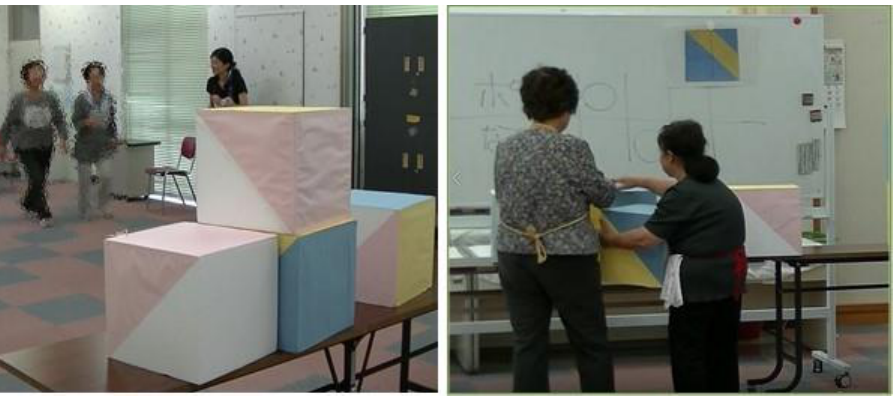
Figure 2. Practicing the cube exercise.